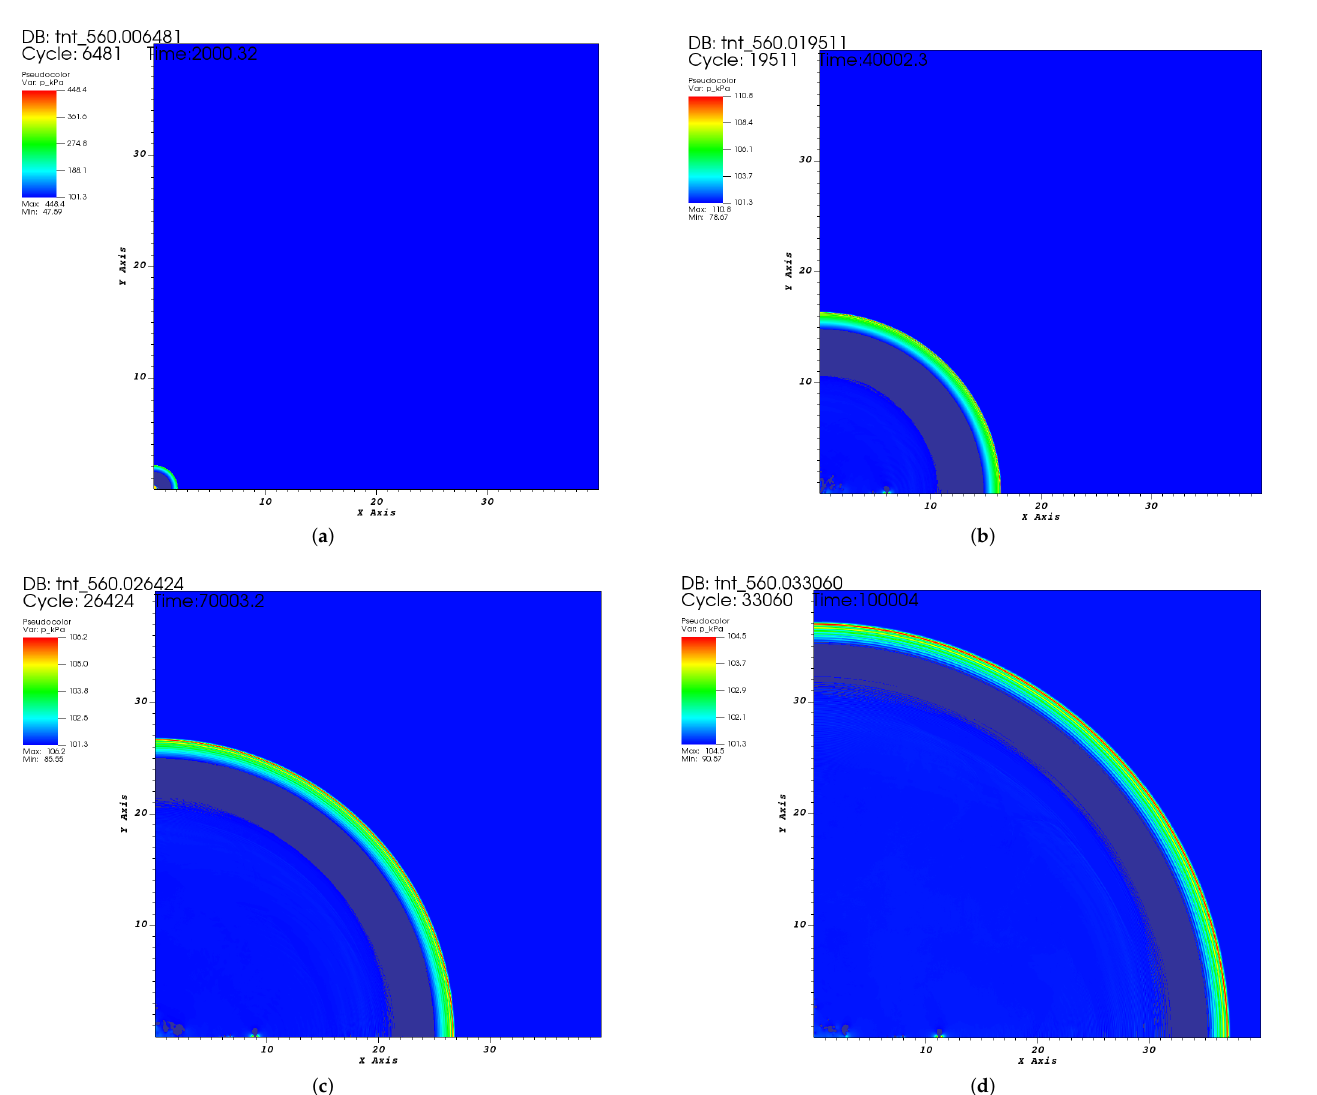
Figure 2. Snapshots of the pressure wave from the 0.90718 kg explosion of hemispherical TNT into air at atmospheric pressure (approximately 101.35 kPa): ( a ) 2 ms, ( b ) 40 ms, ( c ) 70 ms, and ( d ) 100 ms after programmed